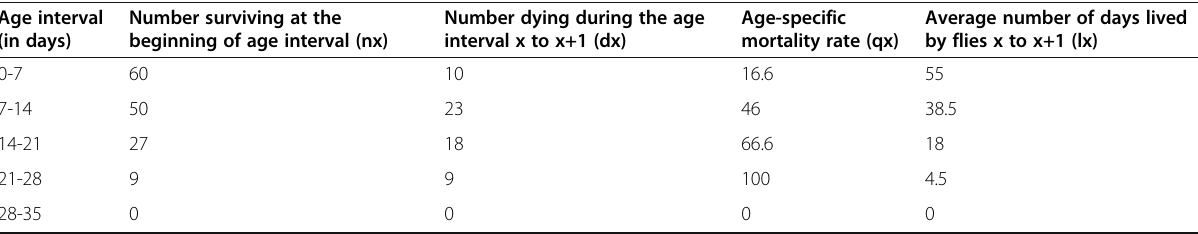
Table 2 Life table depicting survival of D. melanogaster in media with 0.6 mg/L NaF Age interval (in